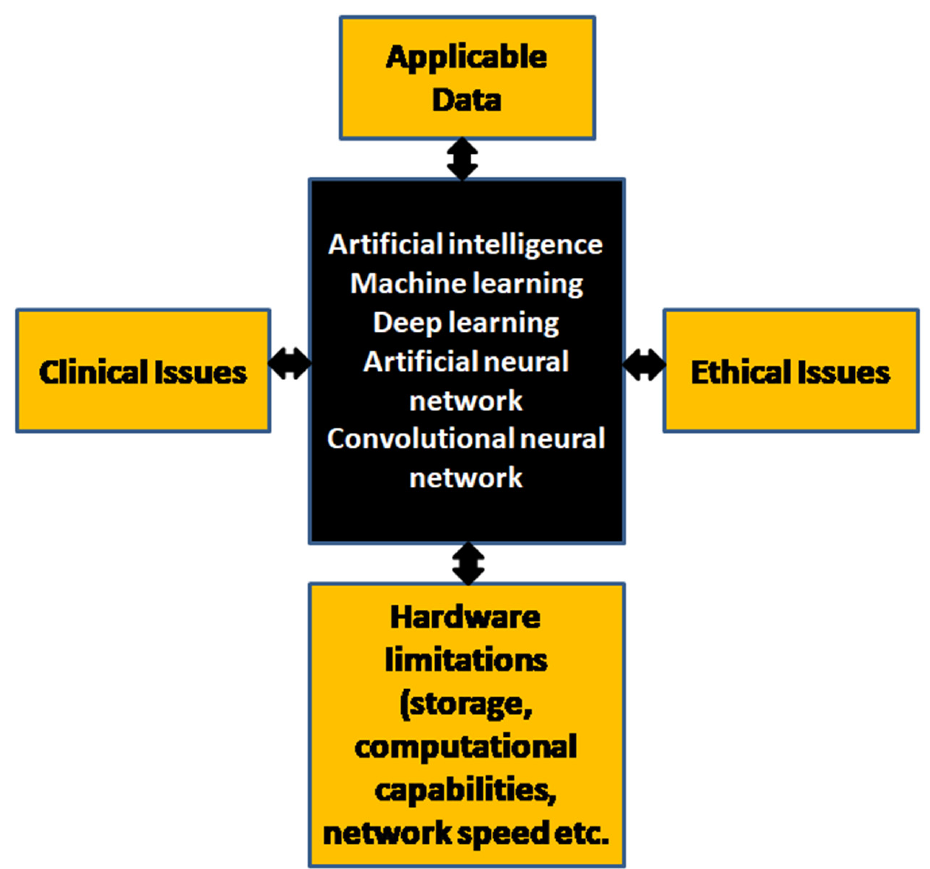
Figure 10. Limitations affecting AI development and deployment (original diagram).